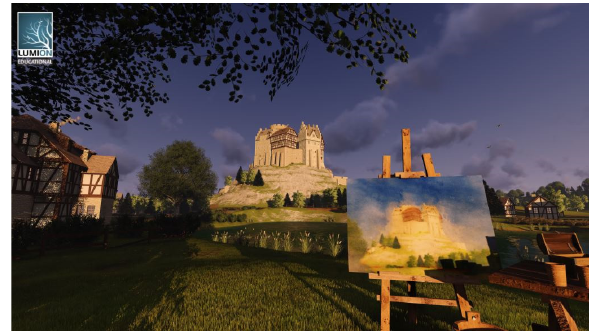
Figure 10. Drawing of the castle as shown in the closing credits of the video